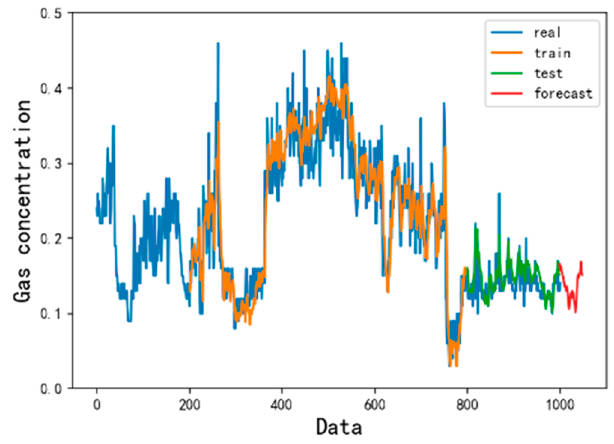
Figure 15. GRU prediction model fitting effect diagram.